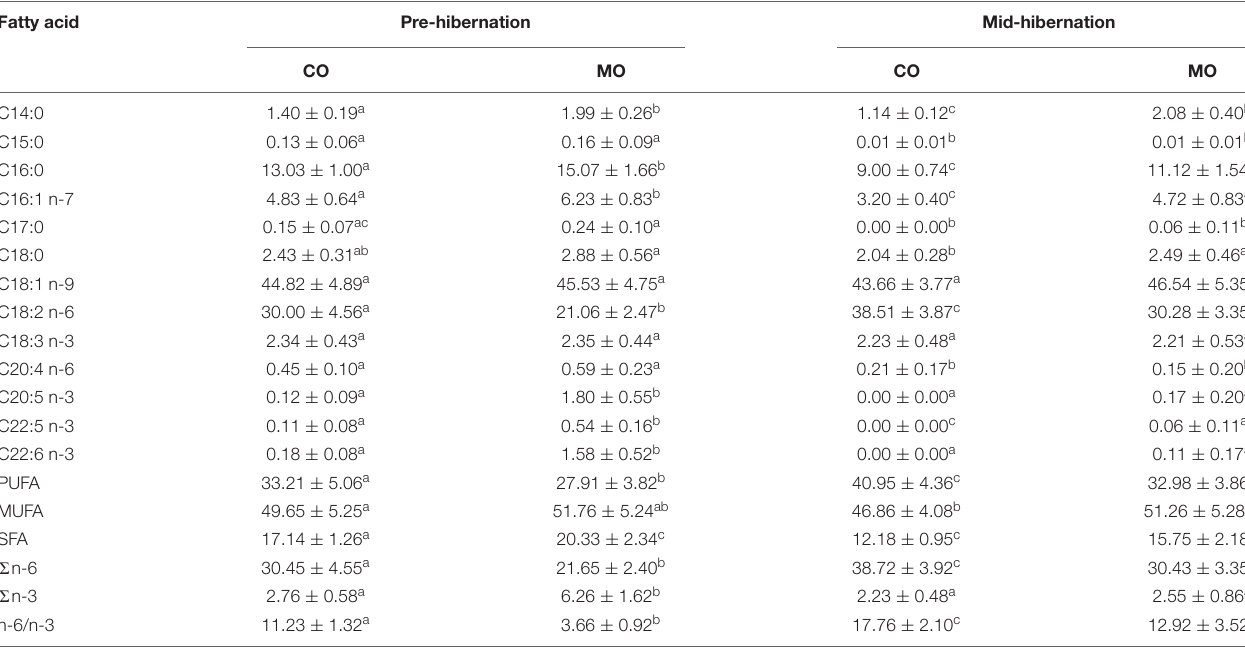
TABLE 4 | Fatty acid proportions (% of total fatty acids), prior to and at mid-hibernation of white adipose tissue total lipids (means ± standard deviation) and ratios of certain fatty acid proportions of garden dormice fed diets enriched with either n-6 fatty acids (“CO”) or n-3 fatty acids (“MO”). Fatty